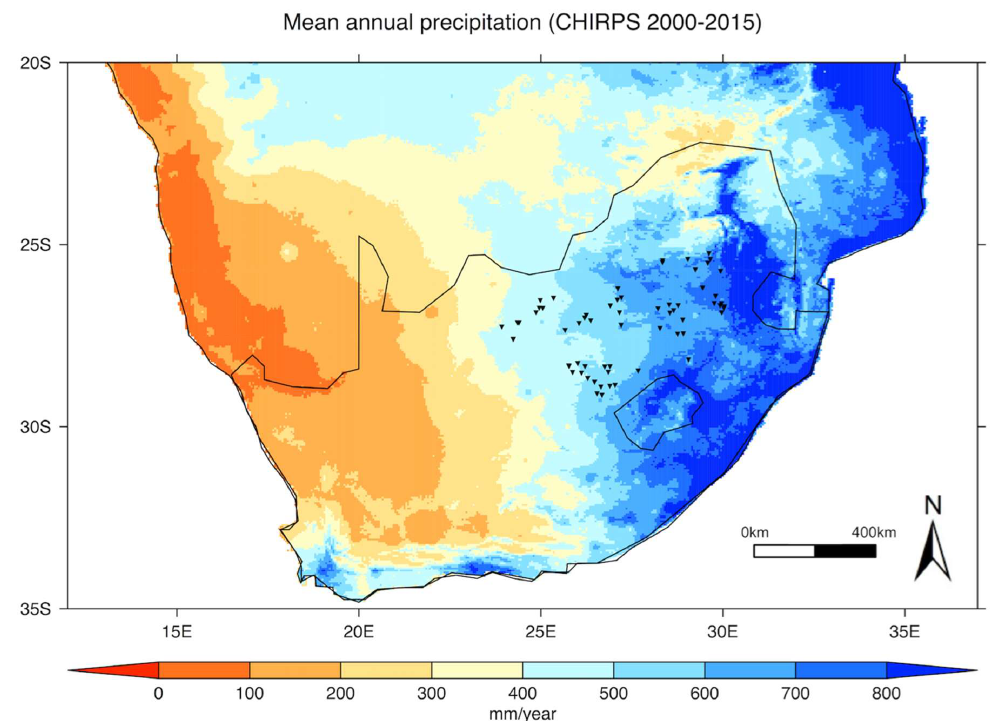
Figure 1. Location of the 60 selected grassland sites, projected on the mean annual precipitation according to the Climate Hazards Group InfraRed Precipitation with Station data (CHIRPS) dataset.